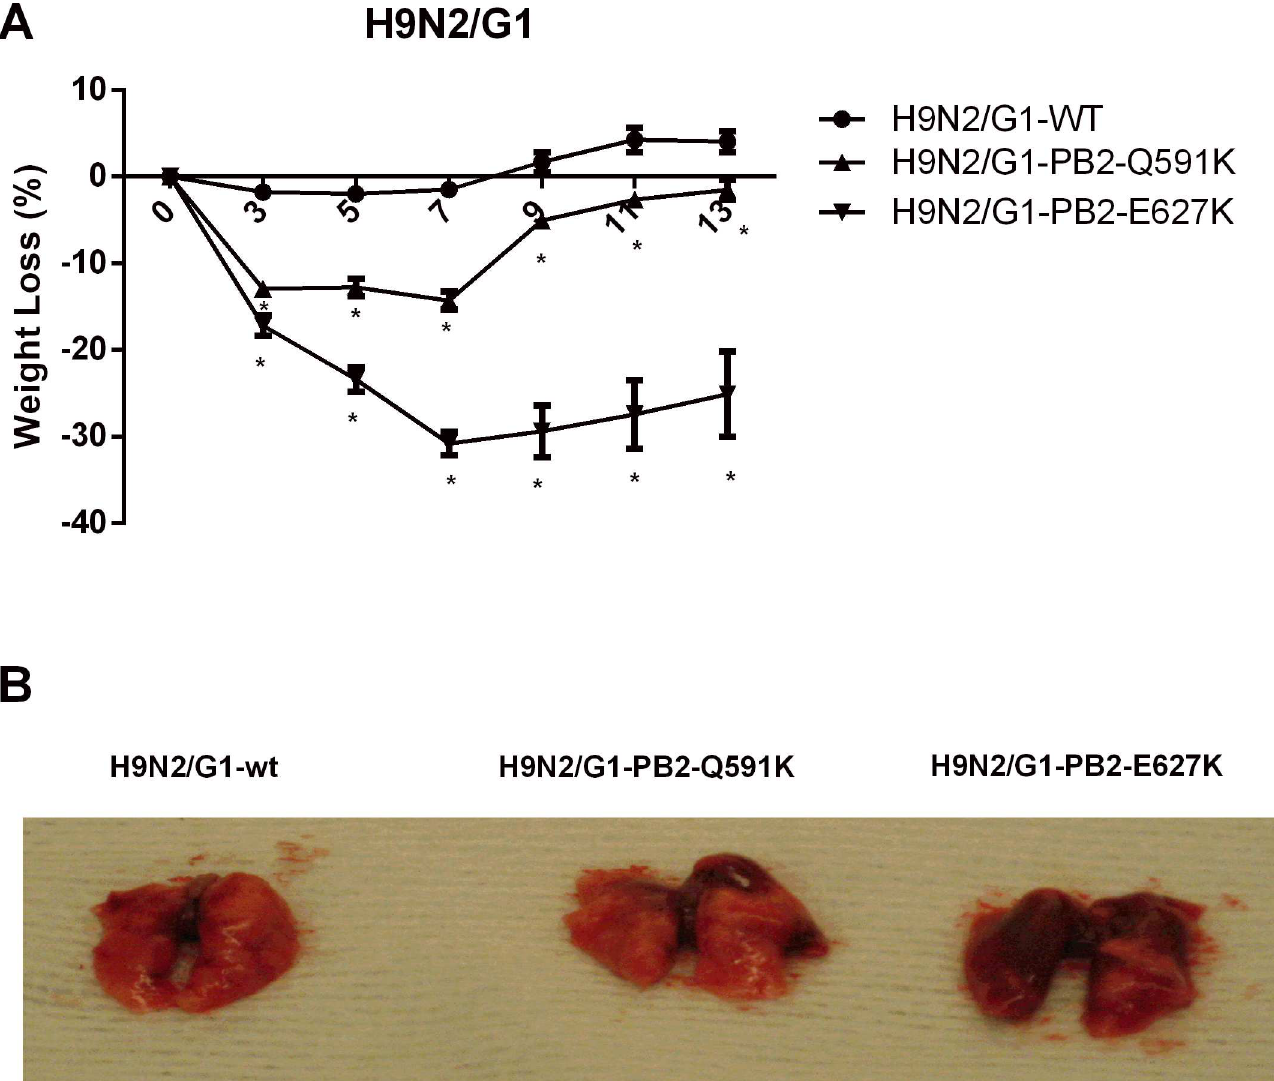
Fig 3. The weight change of the mice infected with the H9N2 and their PB2 variants. Female BALB/c mice were infected intranansally with 1.5x105 PFU of the H9N2/G1 and their PB2 mutants. Weight of the infected mice were expressed as percentagechange compared to the weight at day 0. Results from each time point were expressedas mean ± SD of five mice. * :p < 0.05. The data is the representative results from one of two independent experiments (B) The photographs from the lungs of the mice infected by the H9N2/G1 and their PB2